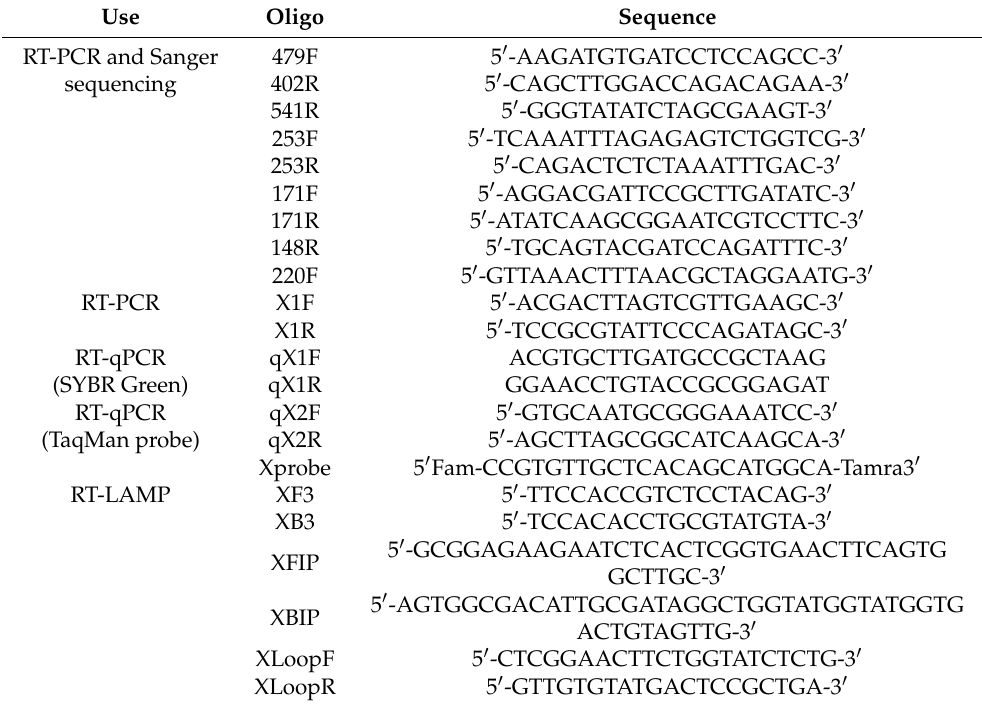
Table 1. Oligonucleotides (primers and TaqMan probe) designed and used in this work. Use Oligo